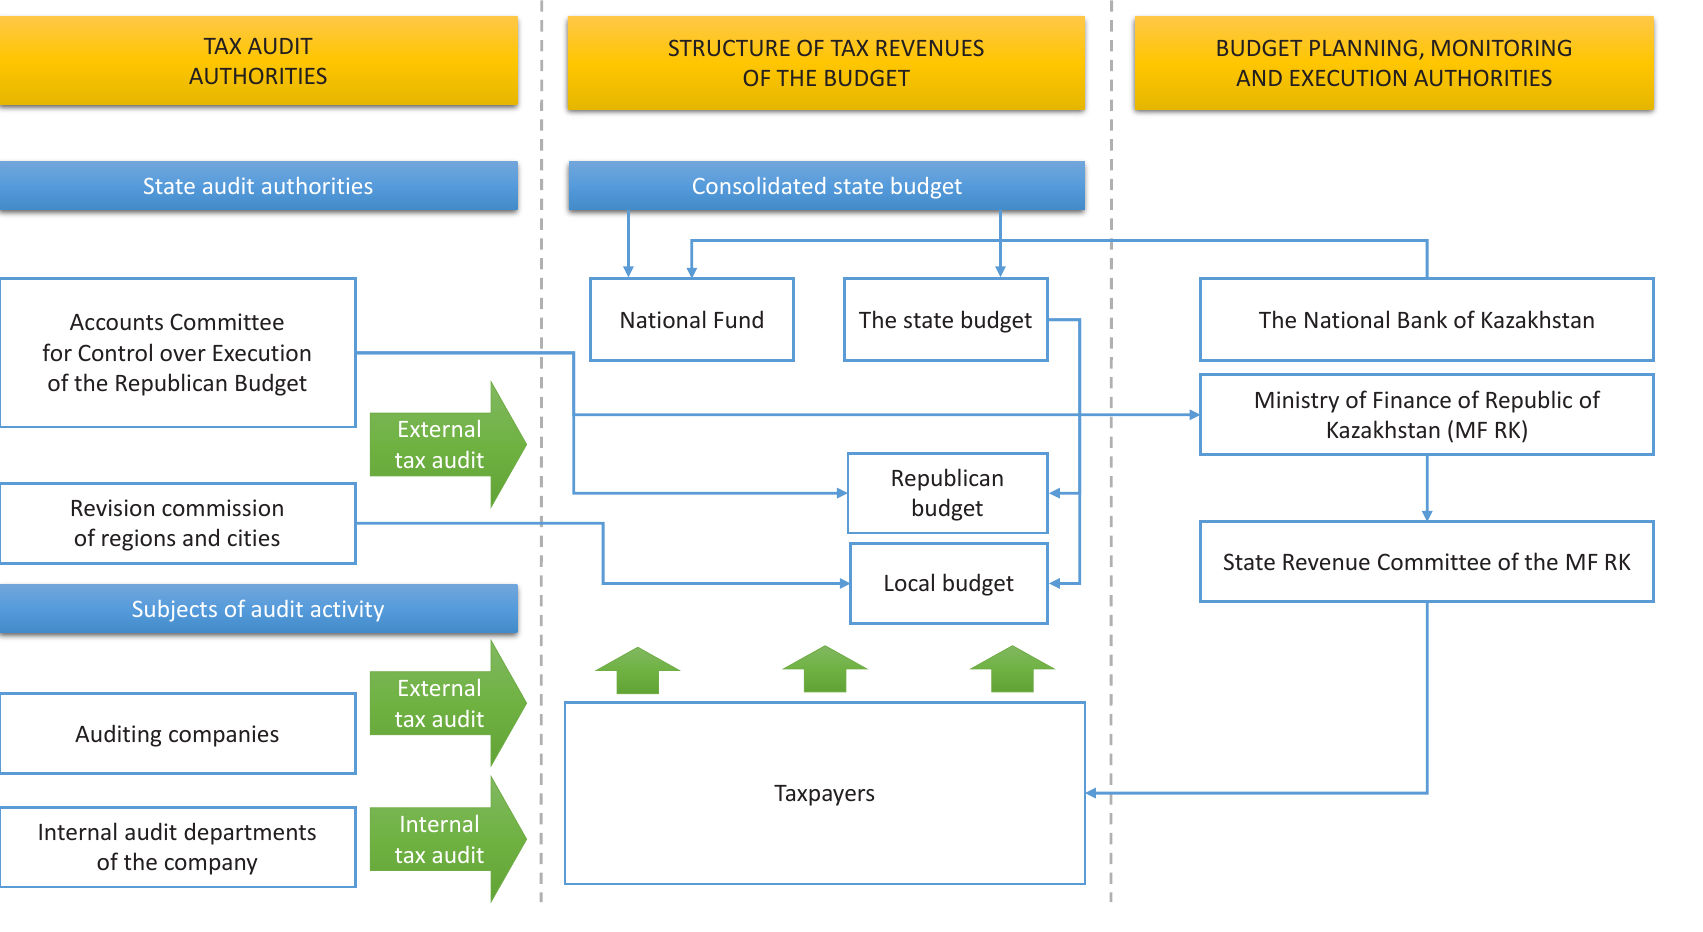
Figure 1. Organizational structure of the tax administration of the Republic of